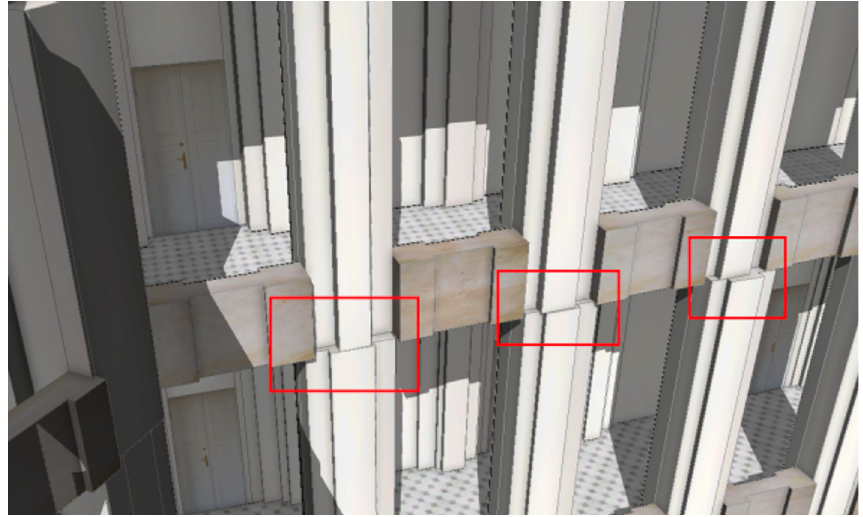
Fig. 4. Inaccurate alignment of the shapes of objects on adjacent